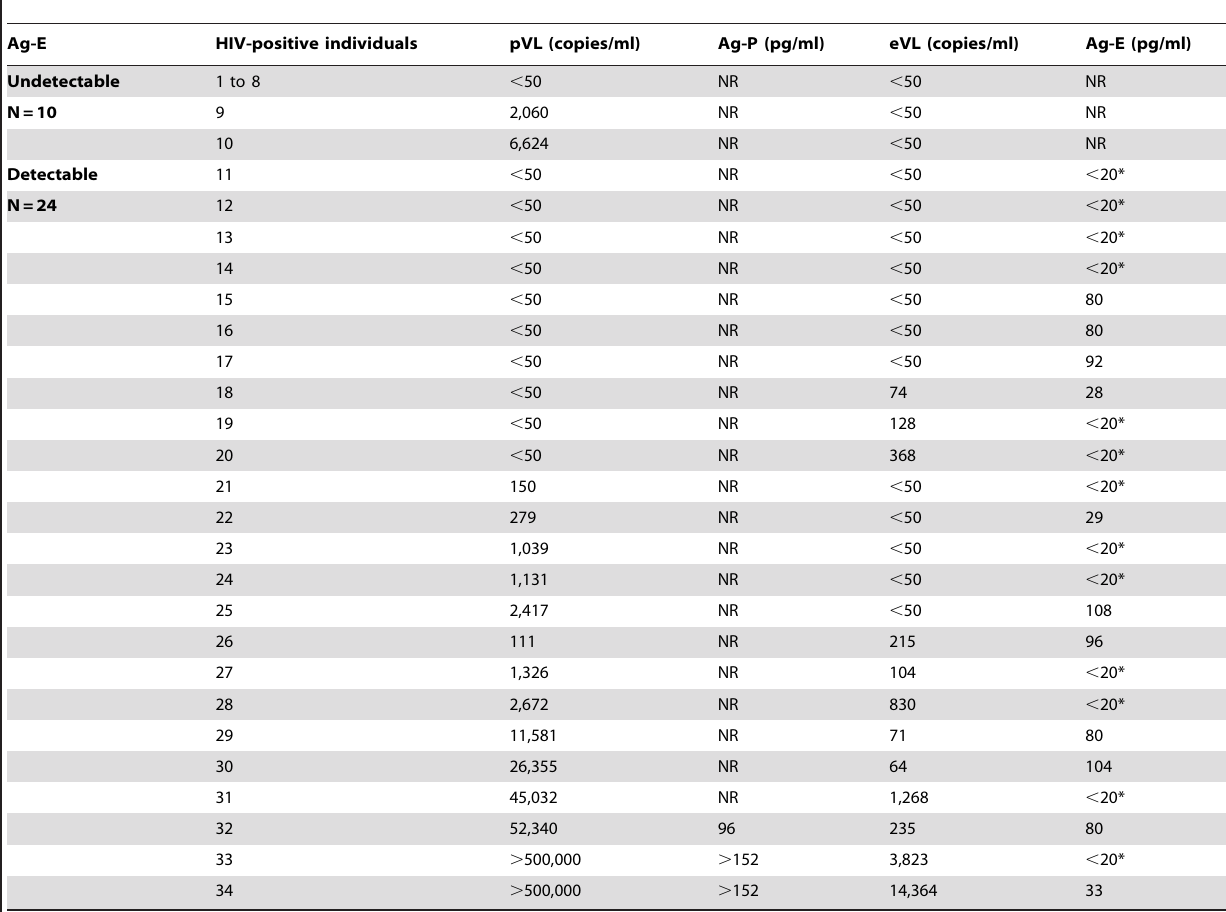
Table 3. Viral load associated to erythrocytes in HIV-positive individuals.